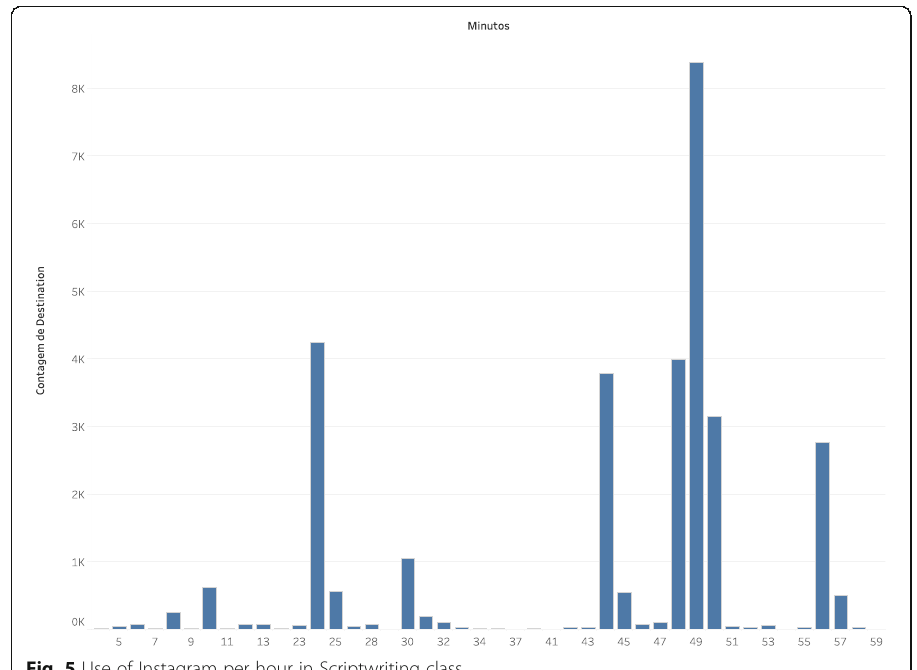
Fig. 5 Use of Instagram per hour in Scriptwriting